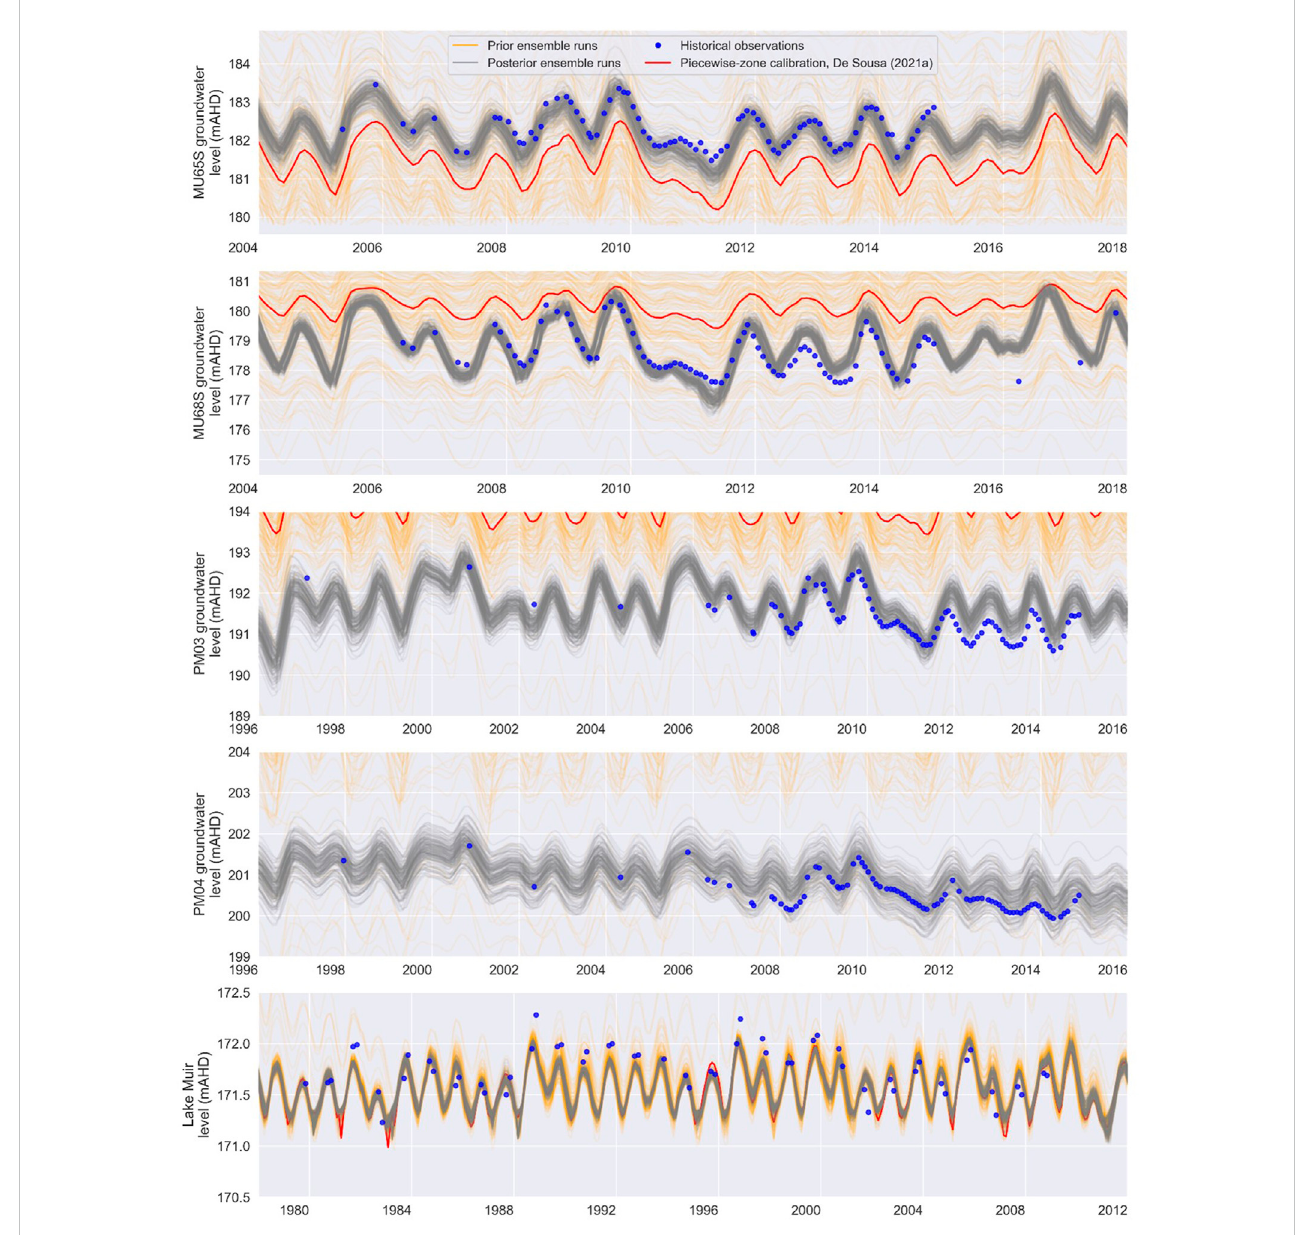
FIGURE 9 Simulated lake and groundwater levels prior and post-calibration at selected